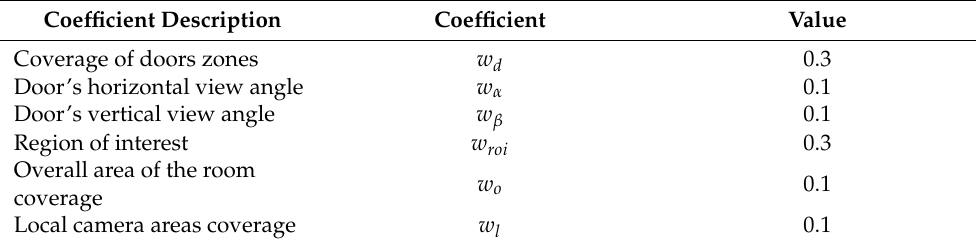
Table 6. Coefficients of the room coverage function.